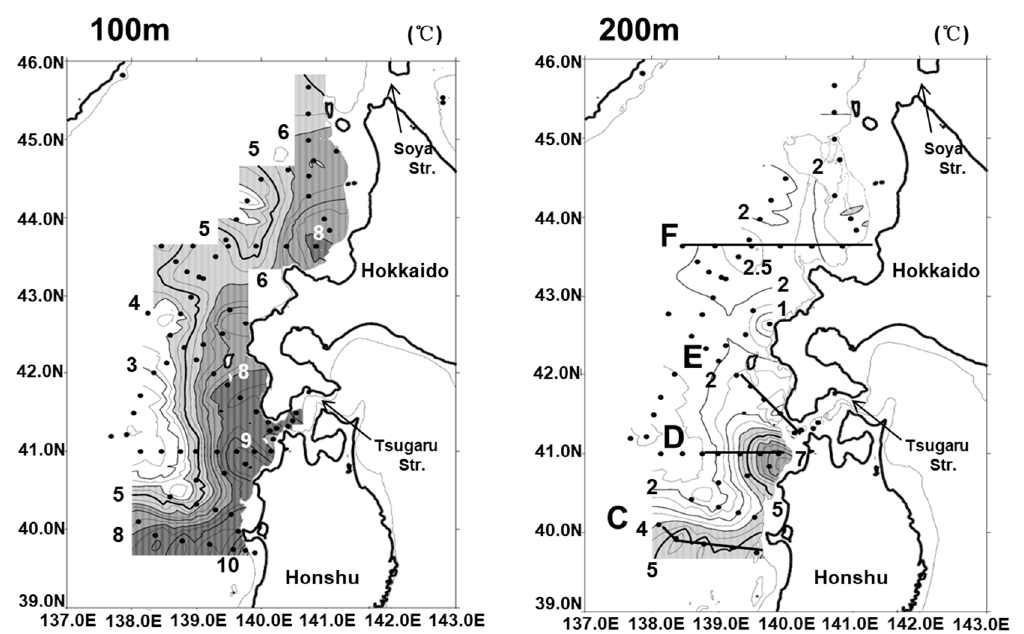
Figure 4. The Horizontal distributions of temperature at the depths of 100 m and 200 min the sea area from the Tsugaru Strait to the west of Hokkaido.